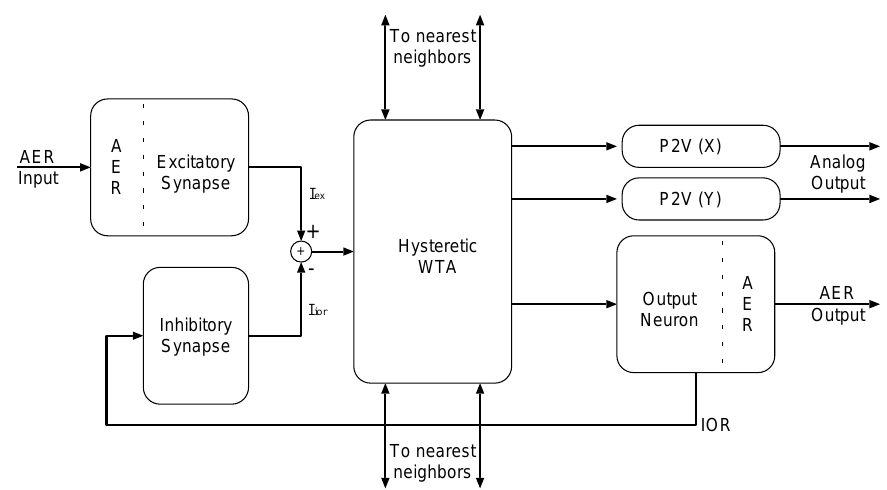
Figure 11 . Block diagram of an AER selective attention chip